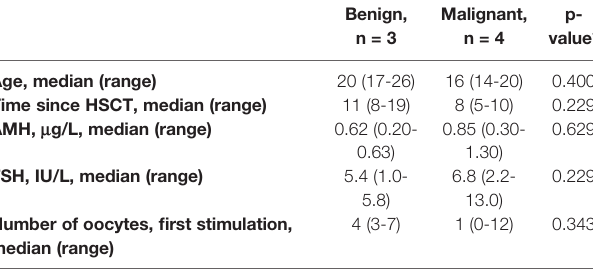
TABLE 4 | Oocyte cryopreservation after HSCT, by